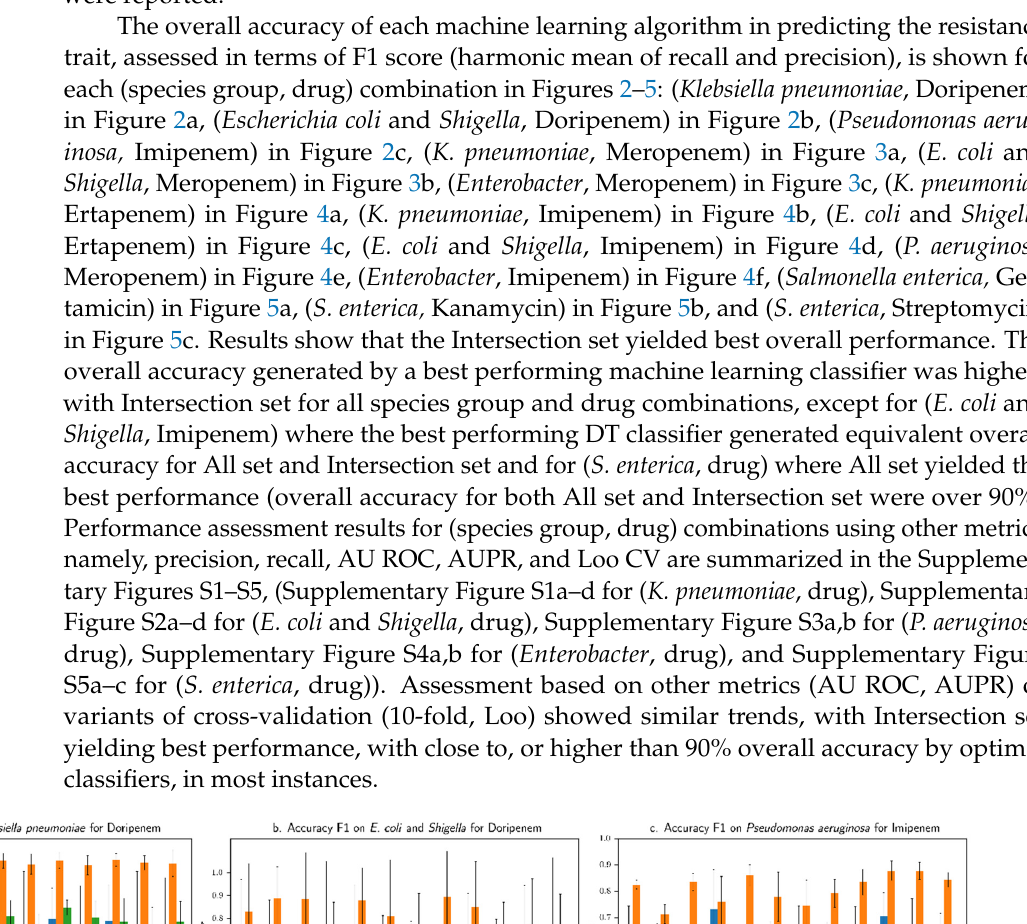
Figure 3. Overall accuracy (F1 score) produced by different machine learning algorithms in predict- ing resistance to Meropenem for ( a ) K. pneumoniae , ( b ) E. coli and Shigella , and ( c ) Enterobacter . “All Set” denotes all genes of a genome of interest, “Intersection Set” contains genes that consistently ranked high in their importance in discriminating resistant from susceptible strains in each round of cross-validation, and “Random Set” contains randomly sampled genes from All Set (same num- ber of genes as in Intersection Set). Performance was assessed for each of three input datasets in a 6- fold cross-validation setting.